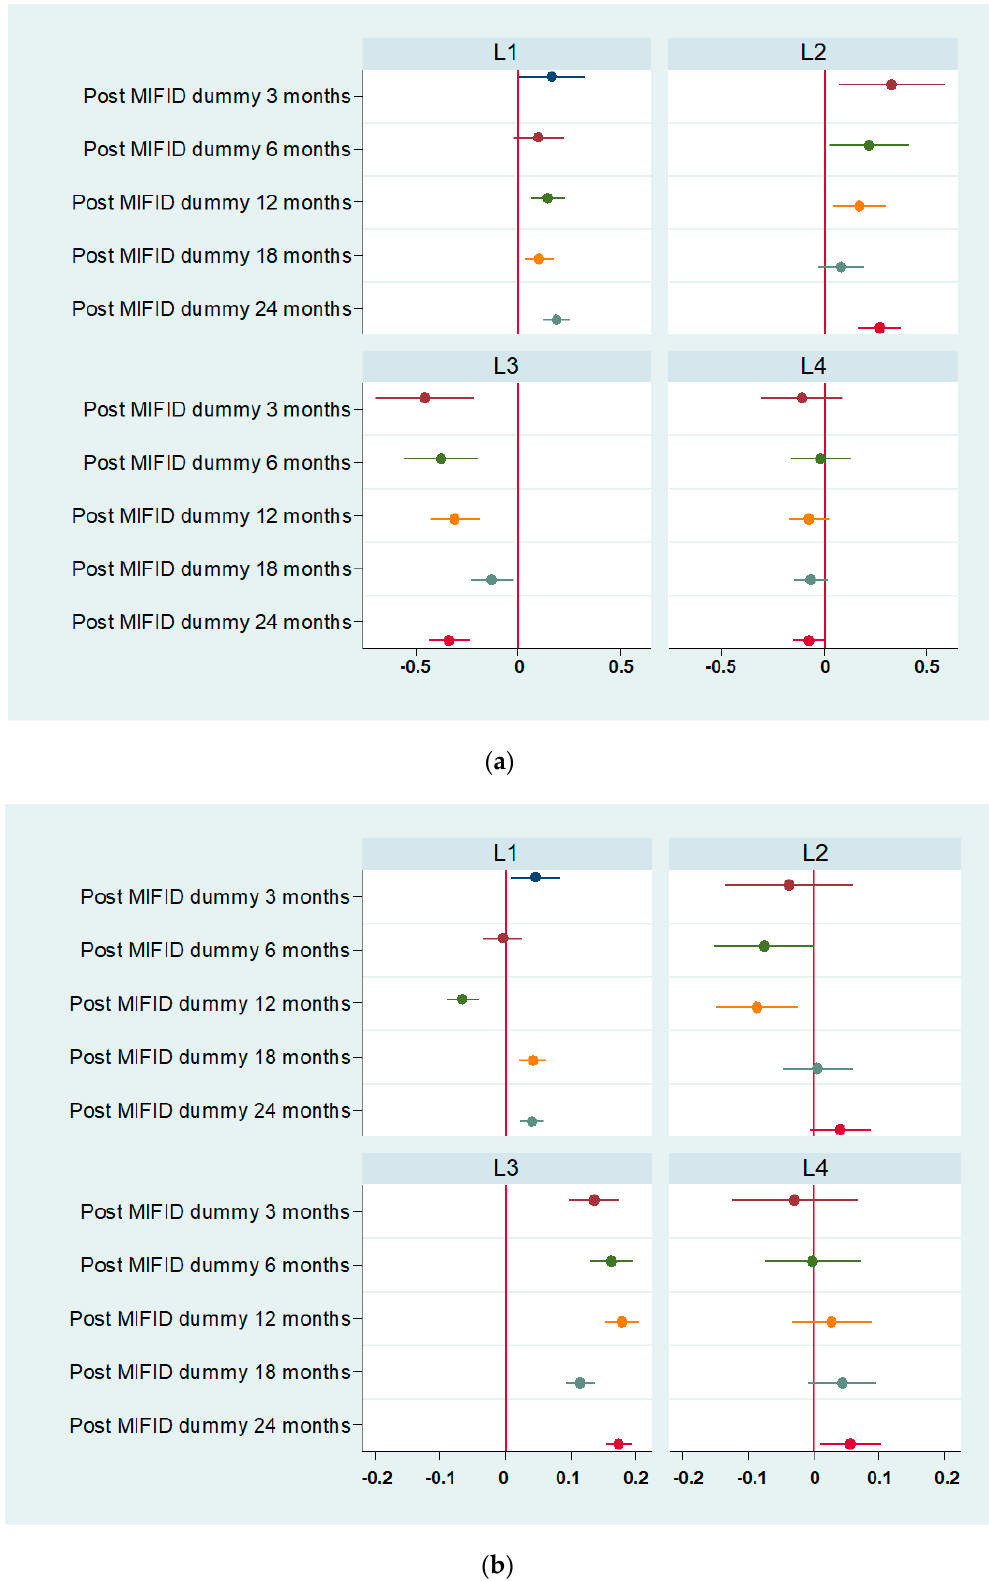
Figure 2. Estimated coefficients for MiFID II, 95% confidence interval: ( a ) BET; ( b ) DAX. Notes: L1-Hui-Heubel liquidity ratio; L2-Amihud ratio; L3-Turnover ratio; L4-Corwin-Schultz bid-ask spread. Source: Own figures.